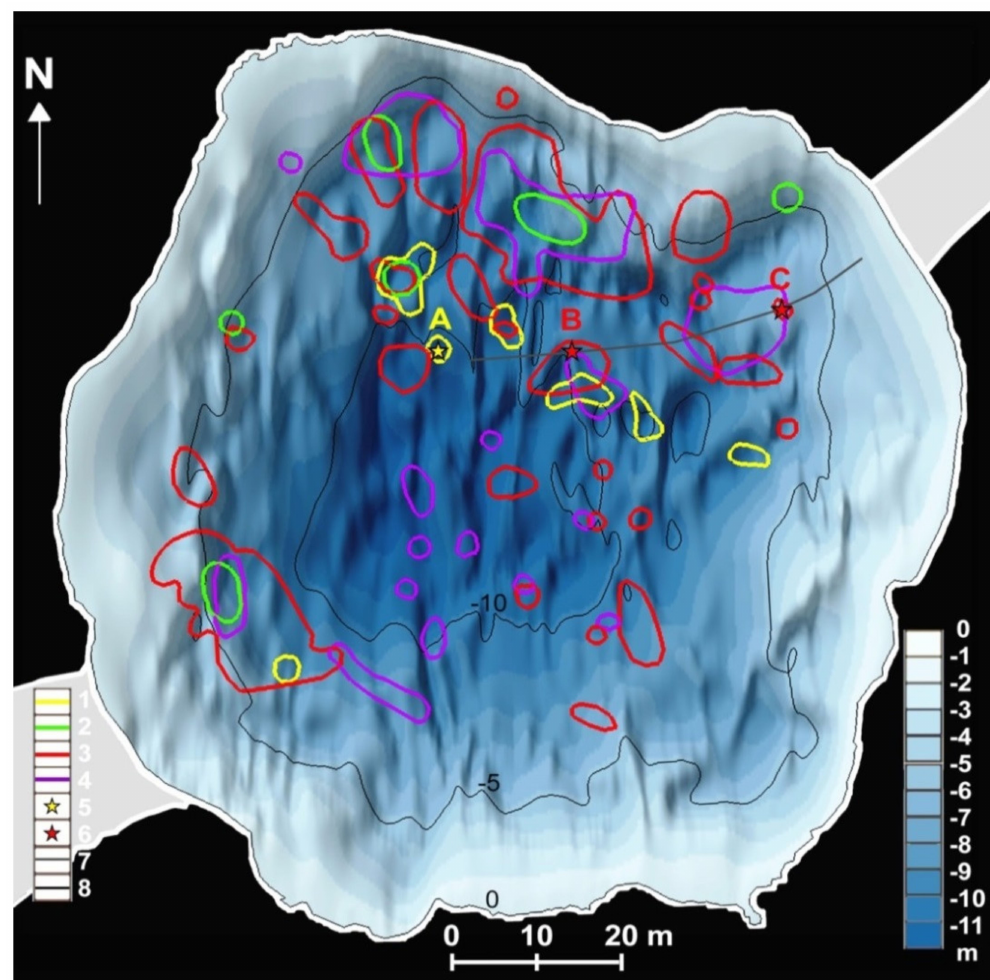
Figure 5. Gas emission areas on the Seyakha Crater C11 in 2017 (1), 2018 (2), 2019 (3) and 2020 (4). Comments: (5) and (6)-areas of gas emission examples in Figure 4a in 2017 and Figure 6B,C in 2018; (7)-echo sounding section presented in Figure 6; (8)-isobaths (m) on the bathymetry base map studied by means of echo sounding on 20 August 2020.